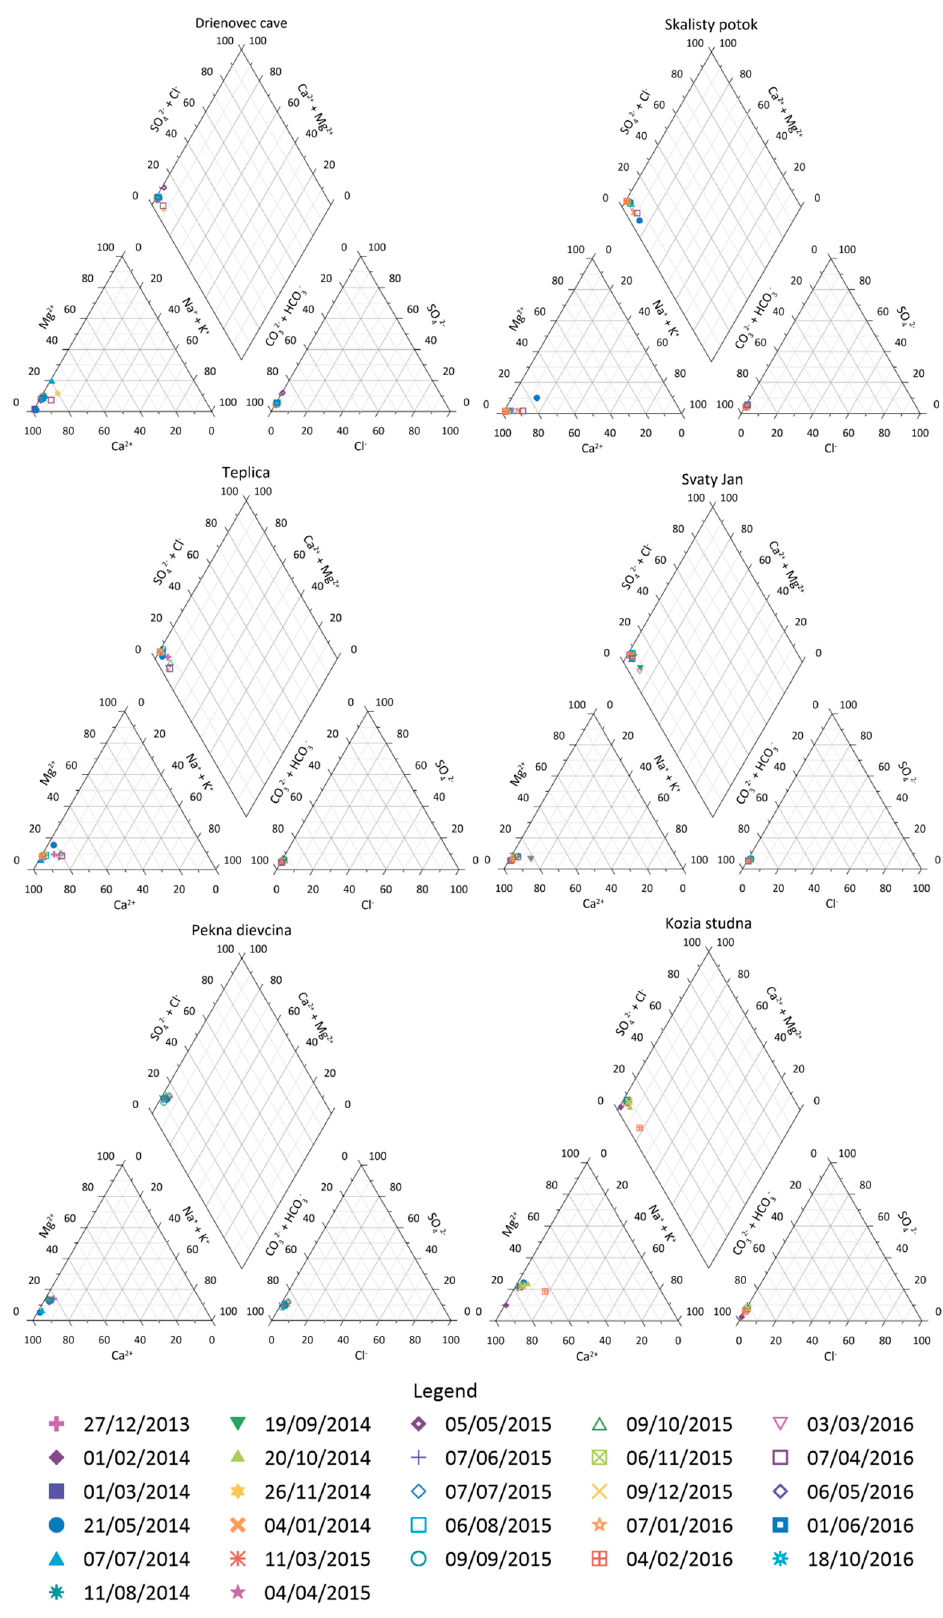
Figure 4. Piper plot of monitored springs. PH values are very similar for all springs. During the monitoring period, pH values varied between 5.7 and 8.7, with average values between 7.4 and 7.9 (Figure 5).